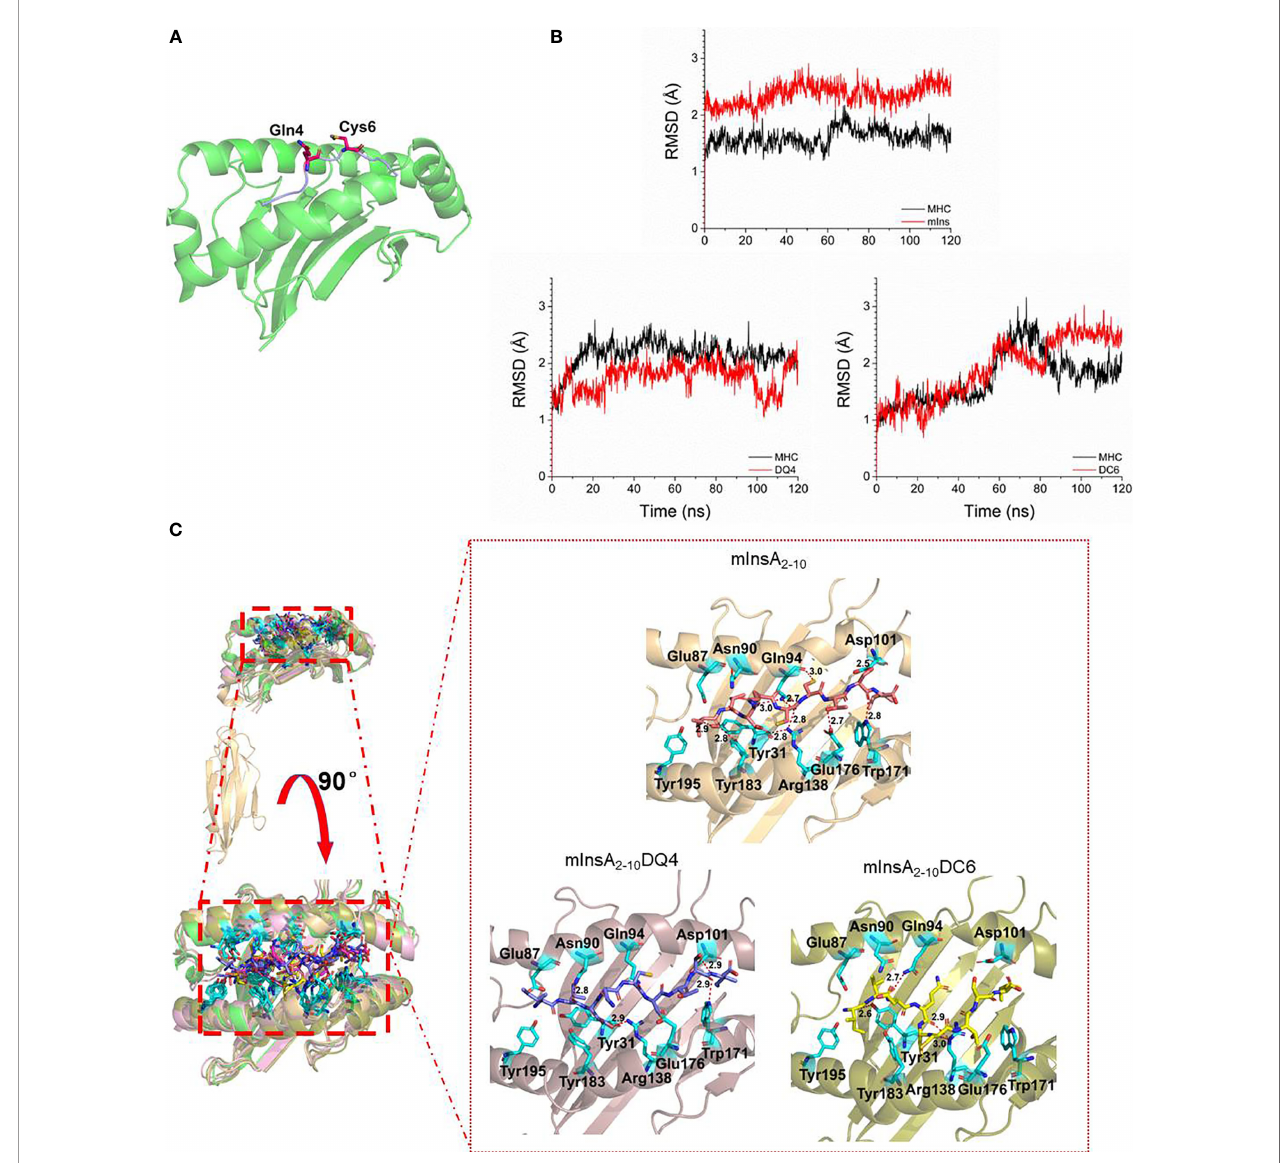
FIGURE 2 | Design of a potential antagonist peptide for mInsA 2-10 . (A) The modeled structure of the HLA-A*0201/mInsA 2-10 complex showed that residues Gln 4 and Cys 6 bulged out of the binding groove, which were the potential TCR contact residues. (B) The RMSD of simulation of complex HLA-A*0201/ epitope, the stable conformation for these three complexes were achieved through 120 ns MD simulation, and the RMSD fl uctuated near 2 Å . (C) The binding mode between HLA-A*0201 and epitopes, these epitopes bound to HLA-A*0201 through stronger hydrogen bonds, but mInsA 2-10 had the most hydrogen